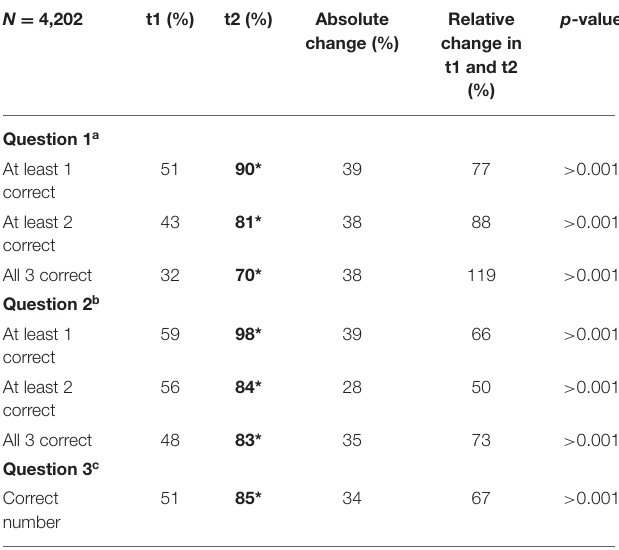
TABLE 1 | Percentage of participants in parental group 1 who selected 1, 2, or 3 correct answers in the SPQ in t1 and